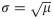
(a),(b) Sales-quantity time series and distribution of 1product, 1store, each day of the week. (c),(d) Sales-quantity time series and distribution of 1product, all stores within the city, each day of the week. In (b),(d), green line shows a Poisson distribution whose mean is the same as the mean of real data. In (d), blue line is a Gaussian distribution whose mean is the same as the mean of real data and the standard deviation is 0.1 times of the mean of real data. In (a),(c), green and blue dashed lines represent the standard deviations of (b),(d), respectively, and black line is the mean of real data. (e) Relationship between mean and standard deviation of sales quantities in the soft drinks category. Regarding plot points, for each day of week: circle, weekly totals: cross, 1 product on 1 store: red, all products on 1 store: blue, 1 product within locality: green, all products within locality: magenta, 1 product within city: cyan, all products within city; black. Black solid line shows σ=μ, and black dashed line shows σ = 0.15μ. (f) Means of (e) with error bars given by the standard deviation. Two red triangles indicate mean and standard deviation of (a) and (c).